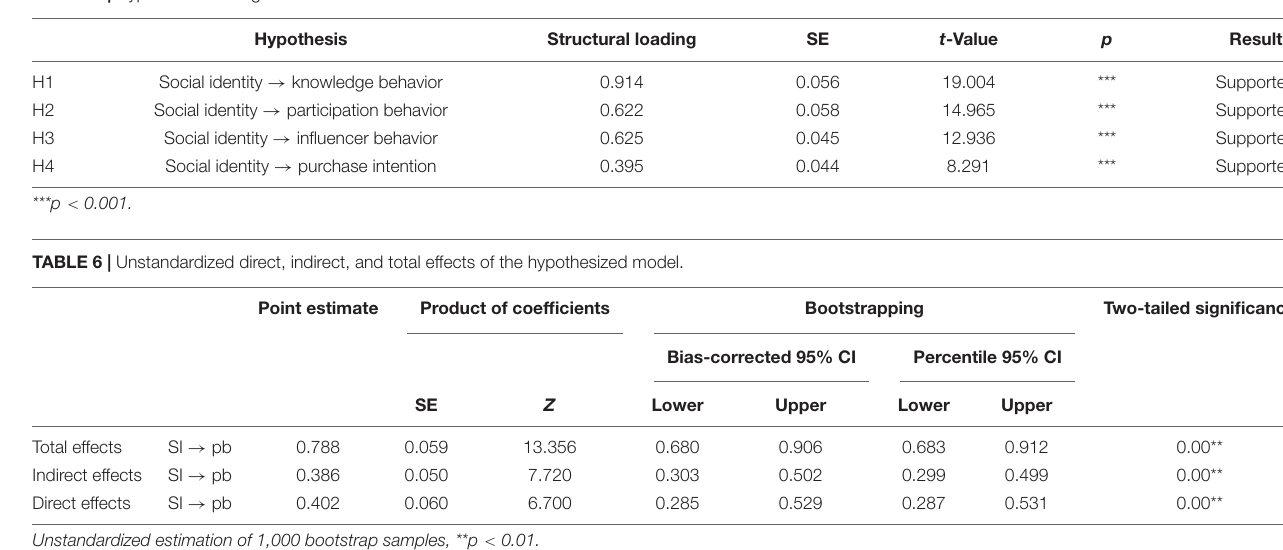
FIGURE 2 | Results of the structural equation model ( N = 520). cogid, cognitive social identity; affid, affective social identity; evaid, evaluative social identity; socialid, social identity; kbh, knowledge behavior; ibh, influencer behavior; pabh, participation behavior; pbh, purchase intention. TABLE 5 | Hypotheses testing.